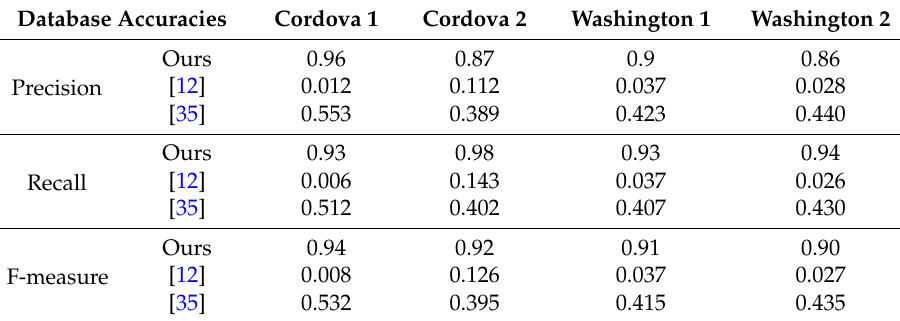
Table 3. Comparative accuracies of lane detection on Caltech datasets.